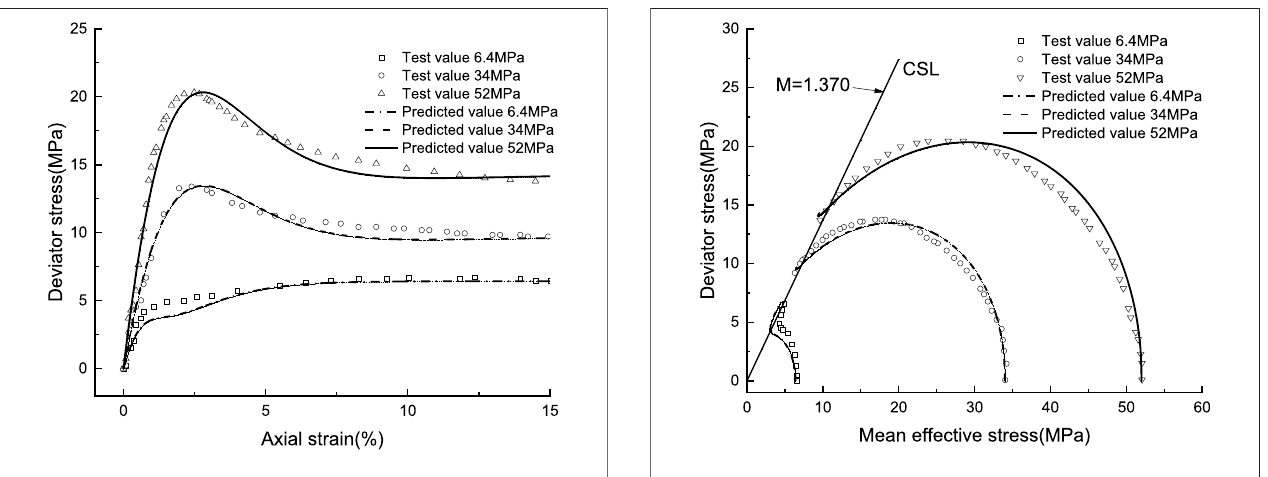
FIGURE 2 | Stress-strain relationship and model prediction results of triaxial undrained shear test on dense sandy soil.